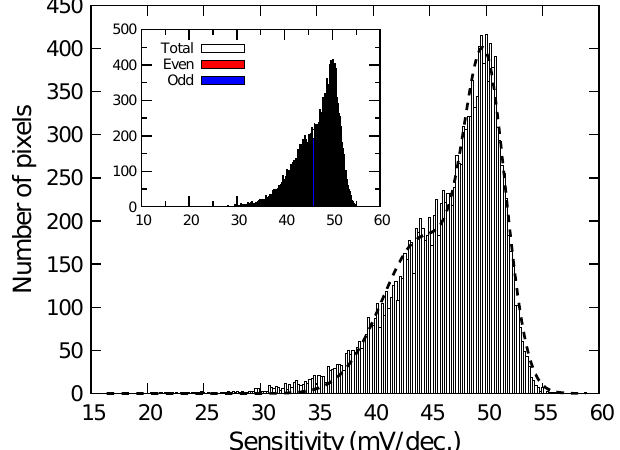
Figure 5. Histogram of redox sensitivity among pixels. Inset depicts sensitivity of even and odd